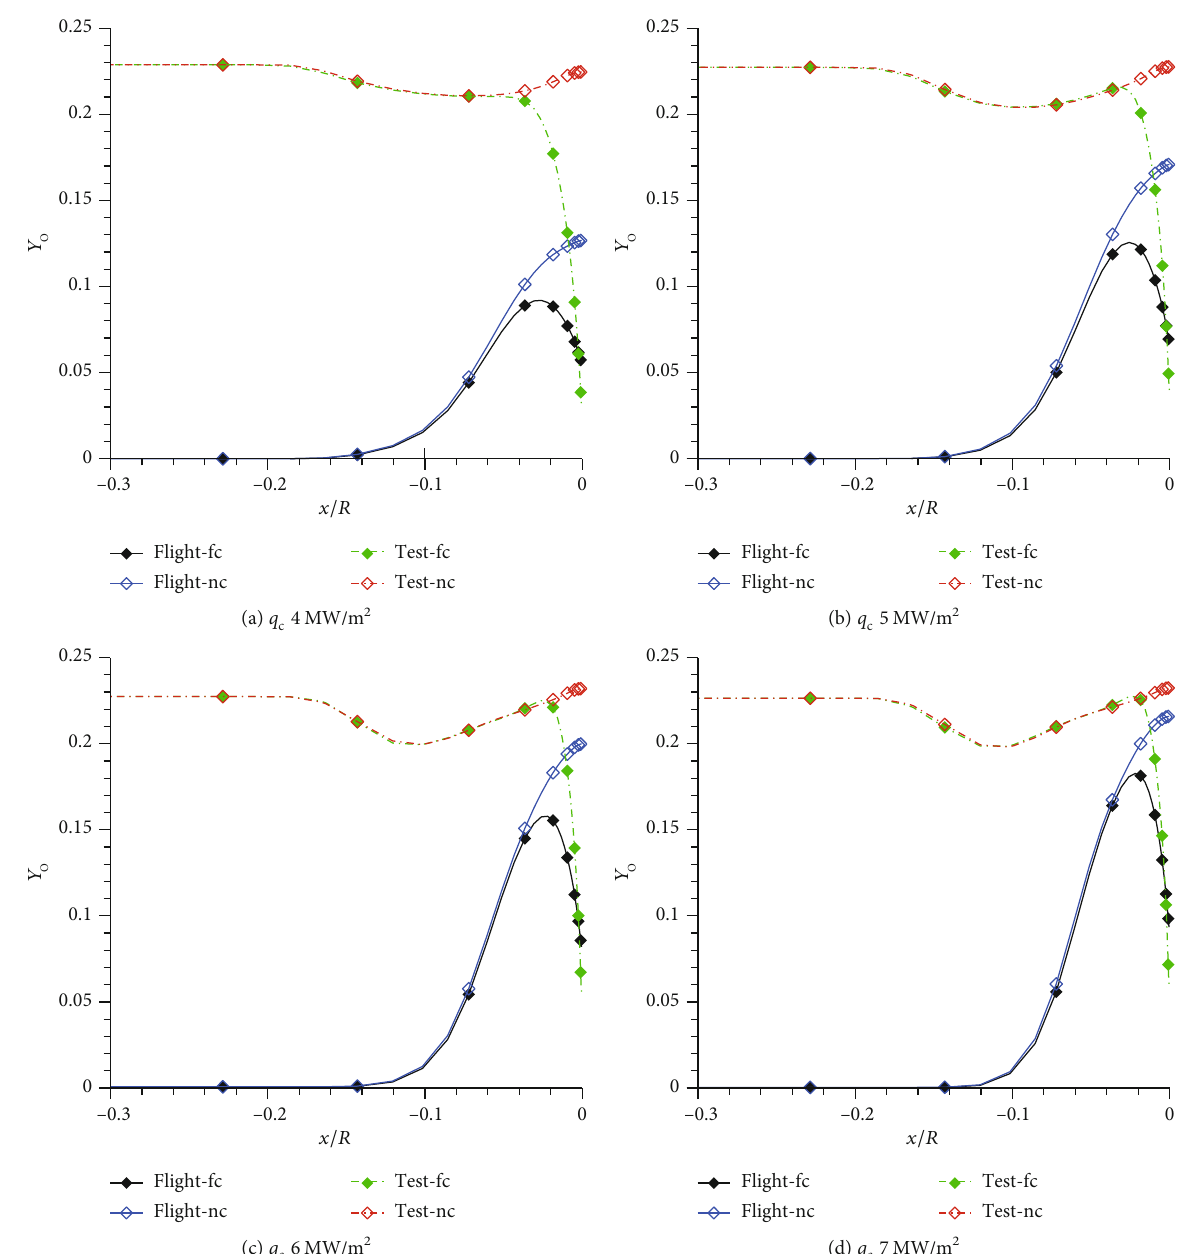
Figure 10: Comparison of oxygen atom mass fractions on the stagnation line for enthalpy 20